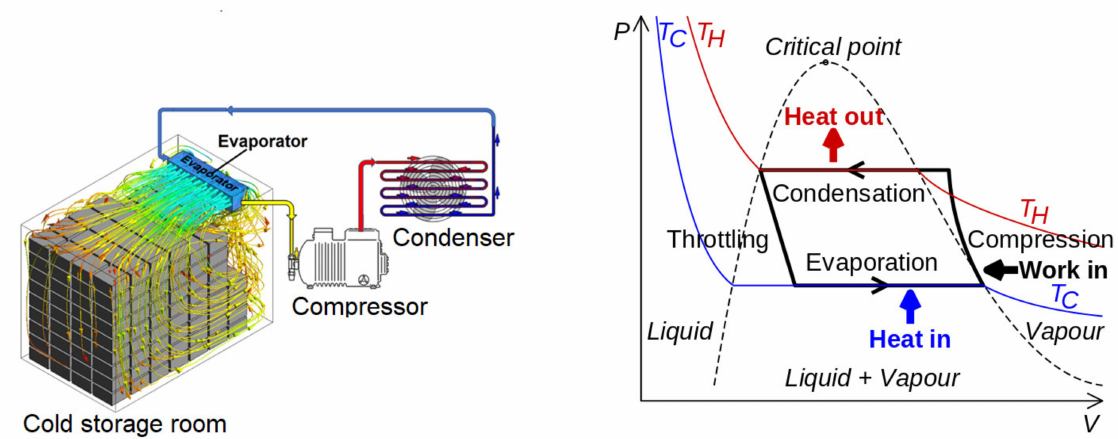
Figure 4. Illustration of a typical vapor compression refrigeration-based cold storage room ( left ) and the corresponding pressure–volume diagram of the refrigeration cycle ( right